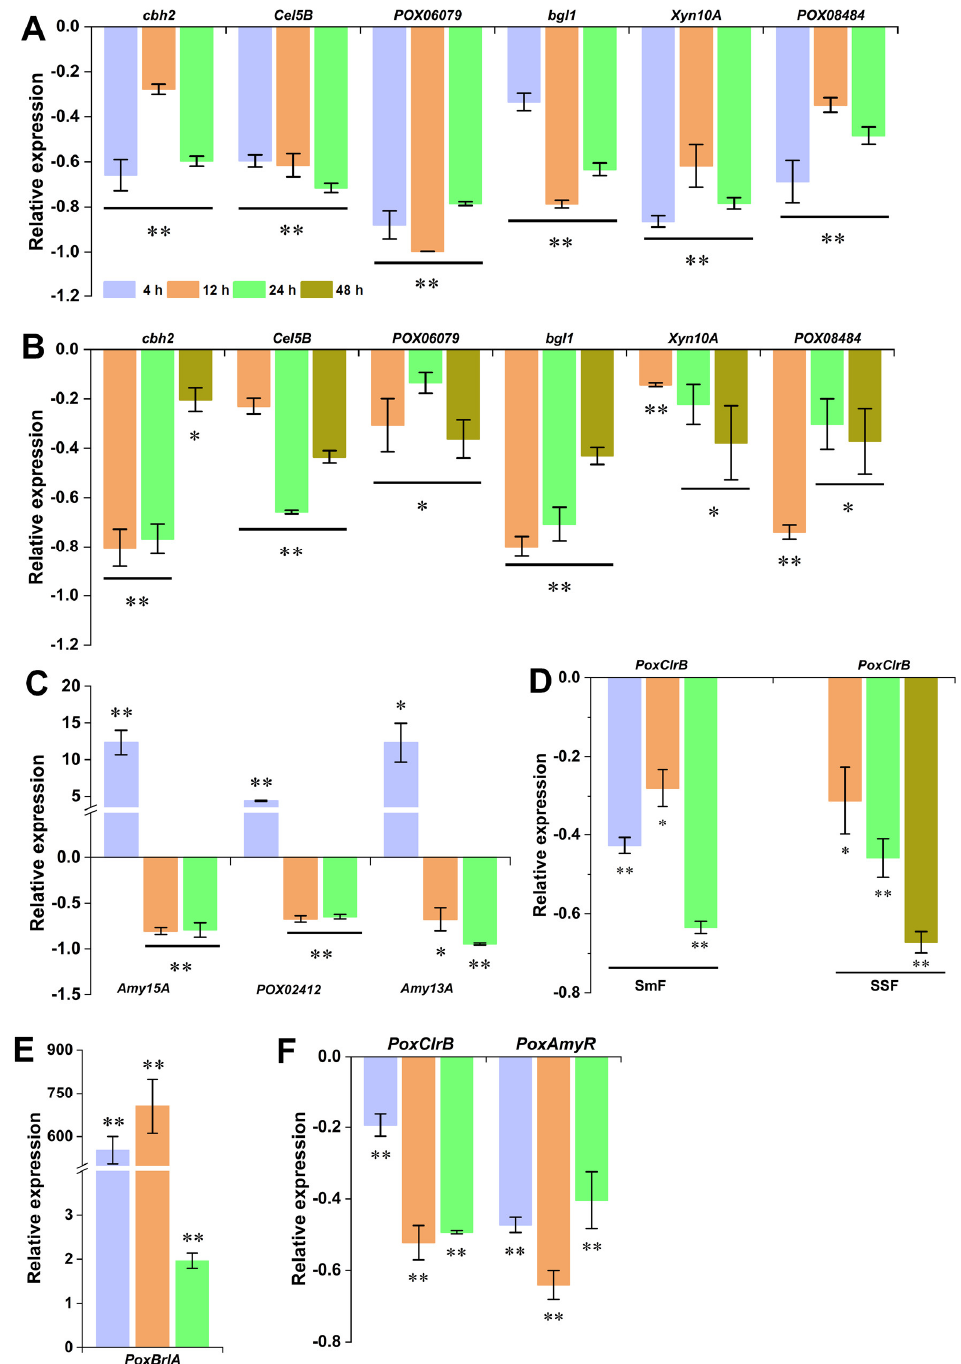
Figure 6. Key gene expression analysis of P. oxalicum strains by RT-qPCR assay. ( A , B ) Expression abundance of major cellulase and xylanase genes under SmF and SSF. ( C ) Expression abundance of major amylase genes. ( D ) Expression abundance of known transcription factor (TF) genes for regulating cellulase and xylanase production. ( E ) Expression abundance of known TF genes for regulating amylase production. ( F ) Expression abundance of BrlA gene involved in asexual development. The transcript levels of each gene were tested at three different times (at 4, 12, and 24 h under SmF and at 12, 24, and 48 h under SSF) after a transfer and were then standardized against those of the control strain Δ PoxKu70 . * p < 0.05 and ** p < 0.01 according to Student’s t -test indicated significant differences between the mutant Δ PoxMKK1 and the control strain.